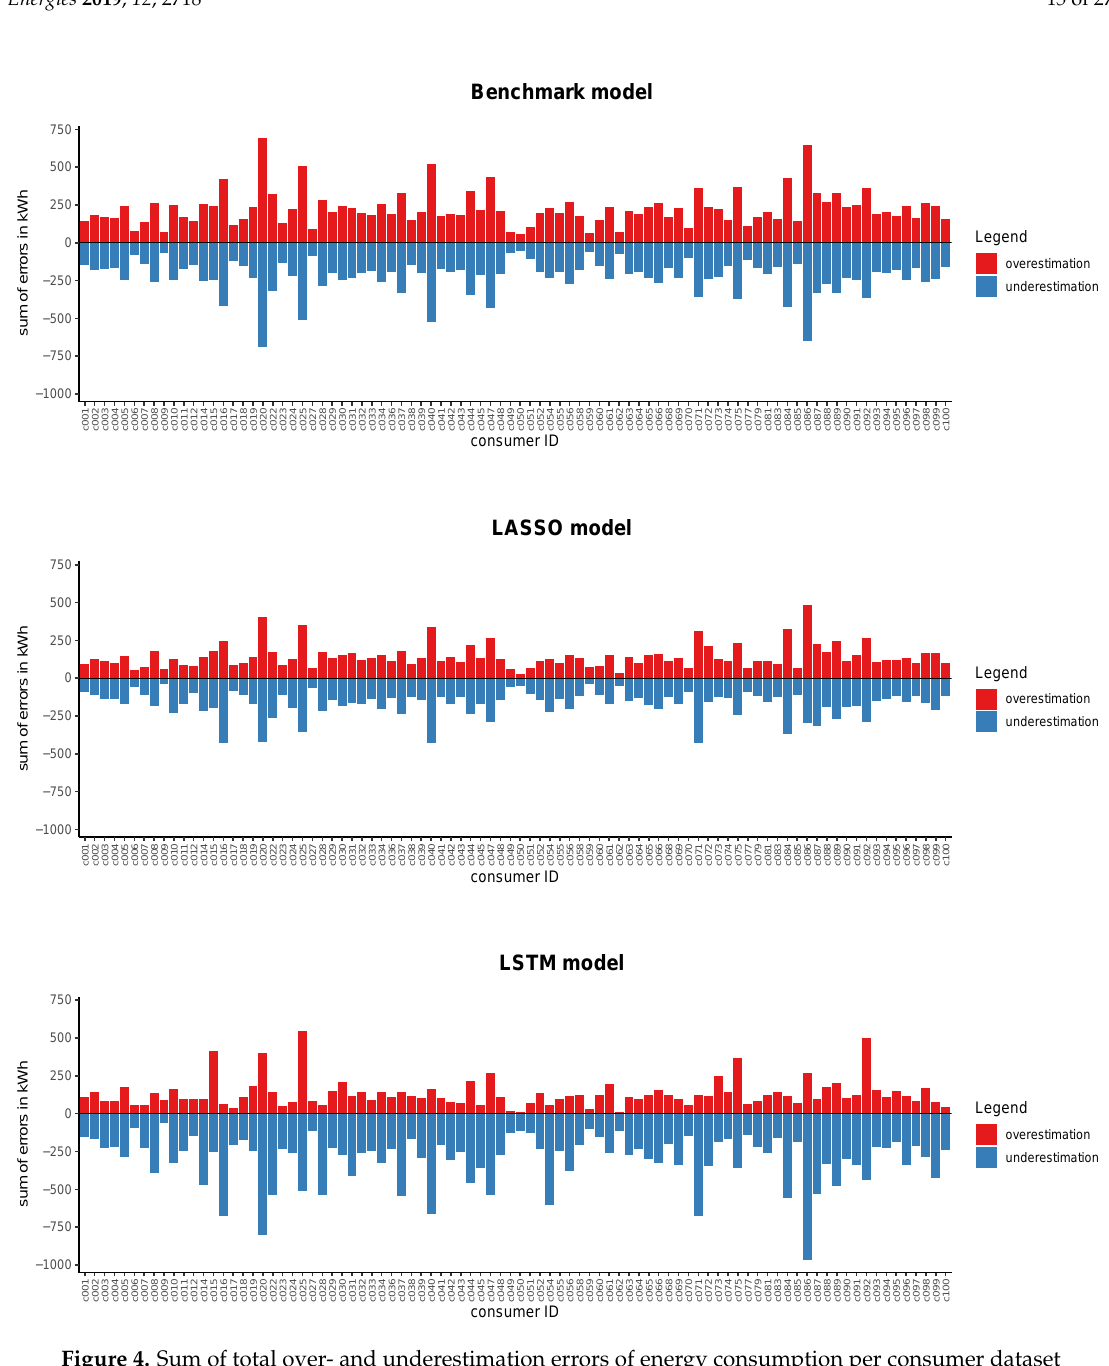
Figure 4. Sum of total over- and underestimation errors of energy consumption per consumer dataset and prediction model. BLEMplotPredErrors (github.com/QuantLet/BLEM/tree/master/BLEMp